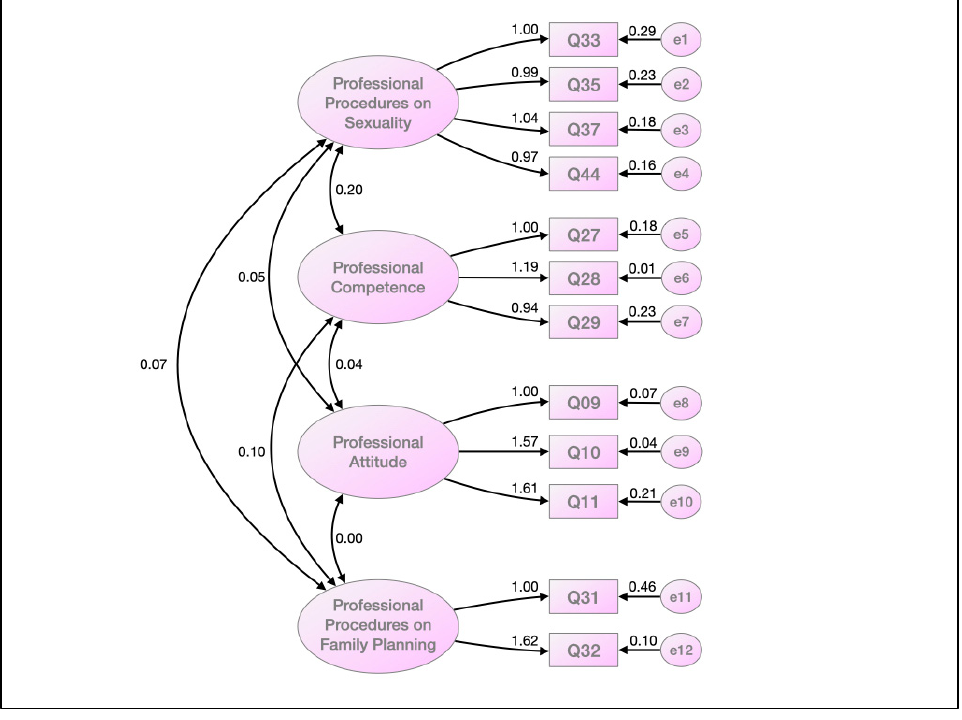
Figure 1. Measures of internal consistency of the construct by confirmatory factor analysis, applying maximum likelihood estimation